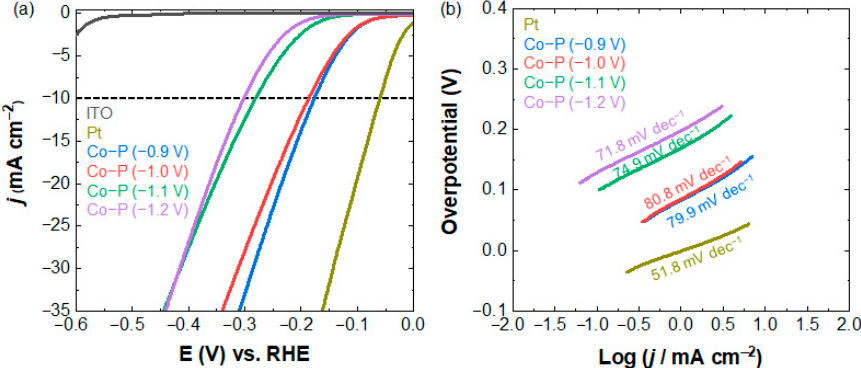
Figure 3. ( a ) HER polarization curves and ( b ) corresponding Tafel plots of electrodeposited Co-P and Pt electrocatalysts on ITO substrate.